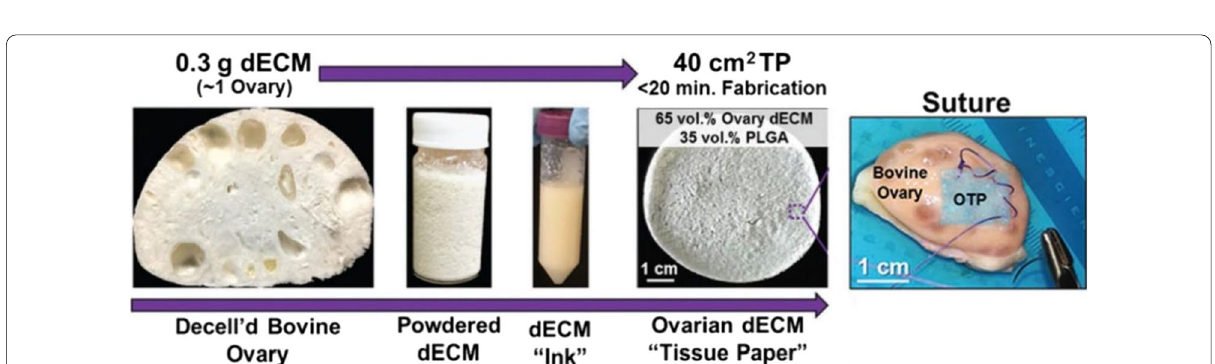
Fig. 5 Re-transplantation of “tissue paper” made from bovine ovarian dECM tissue. Reproduced with permission from